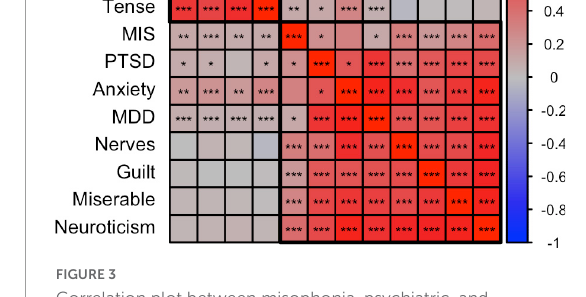
FIGURE2 Correlation plot between misophonia and audiological traits. SNP-based genetic correlations were calculated between misophonia and 10 audiology traits using LD-score regression (LDSC). * p < 0.05, ** p < 0.01, *** p < 0.001, false discovery rate (FDR) adjusted across all traits combinations. See Supplementary Table 1 for abbreviations.